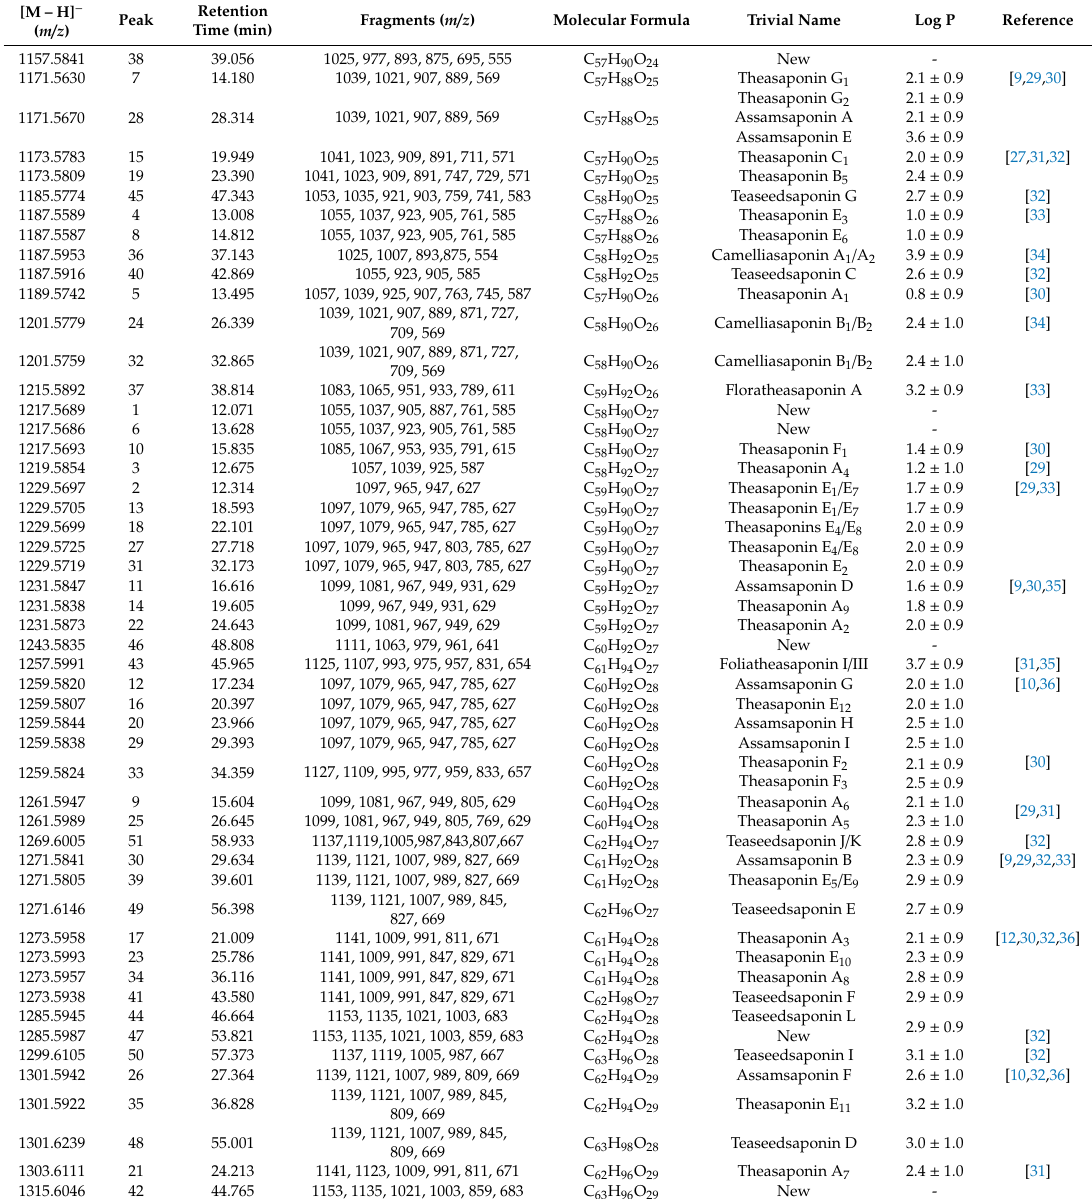
Table 1. Saponins detected in the crude extract of C. sinensis seeds by UPLC-PDA-QTOF-MS /